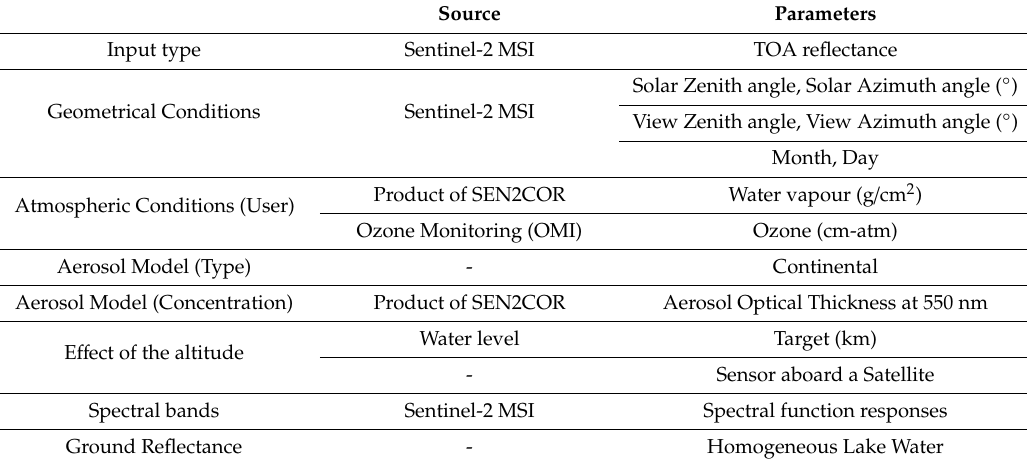
Table 2. Input parameters of 6SV model applied to Sentinel-2